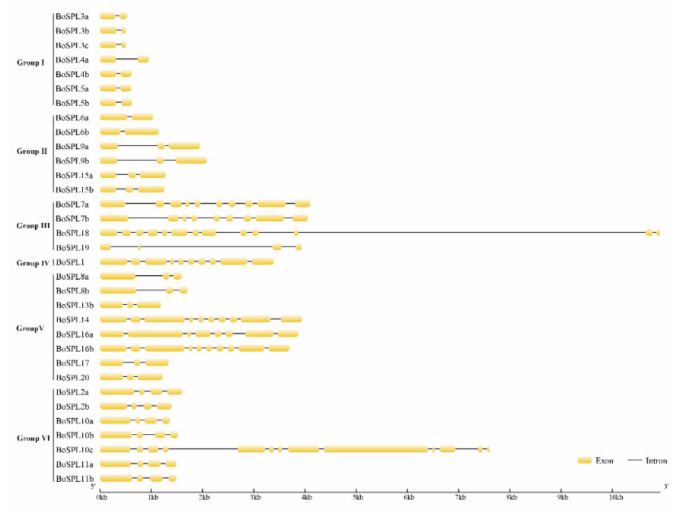
Figure 4. Gene structures of BoSPL genes. The structures of BoSPL genes were plotted using yellow boxes representing exons, black lines representing introns. The scale on the bottom is in the unit of kilobase (Kb).